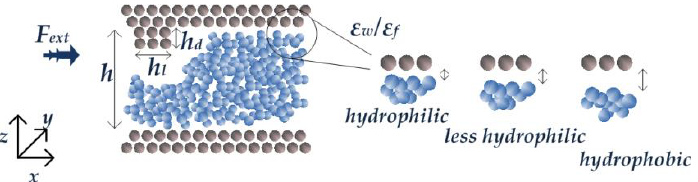
F is the driving force ap- Figure 1. Channel model, with y -direction normal to the page, where F ext is the driving force applied Figure 1. Channel model, with y -direction normal to the page, where ext in x -direction, the channel height is h , the length of the grooves is h l and the height is h d . The ratio of h and the height is h . plied in x -direction, the channel height is h , the length of the grooves is l d wall-to-fluid interaction ε w / ε f defines how close fluid atoms approach the wall.   defines how close fluid atoms approach the wall. The ratio of wall-to-fluid interaction w f A flow originates due to the application of an external force F ext equally applied to all F equally applied to fluid particles, while the system temperature remains constant through the application of ext Nos é –Hoover thermostats in the NVT ensemble. Depending on the simulation, various time steps have been considered. In most cases, each simulation begins with an NVE equilibration stage; at the second stage, fluid particles attain random velocities and, finally, consecutive NVT simulations are performed to provide simulation outputs, each one for at least 20 ns total time, which are averaged to provide the final parameter